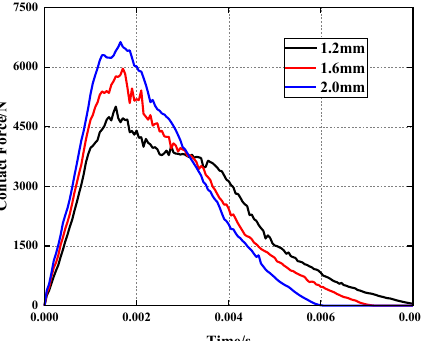
Figure 10. Comparison of the contact force history of the impactor under different face sheet thicknesses.